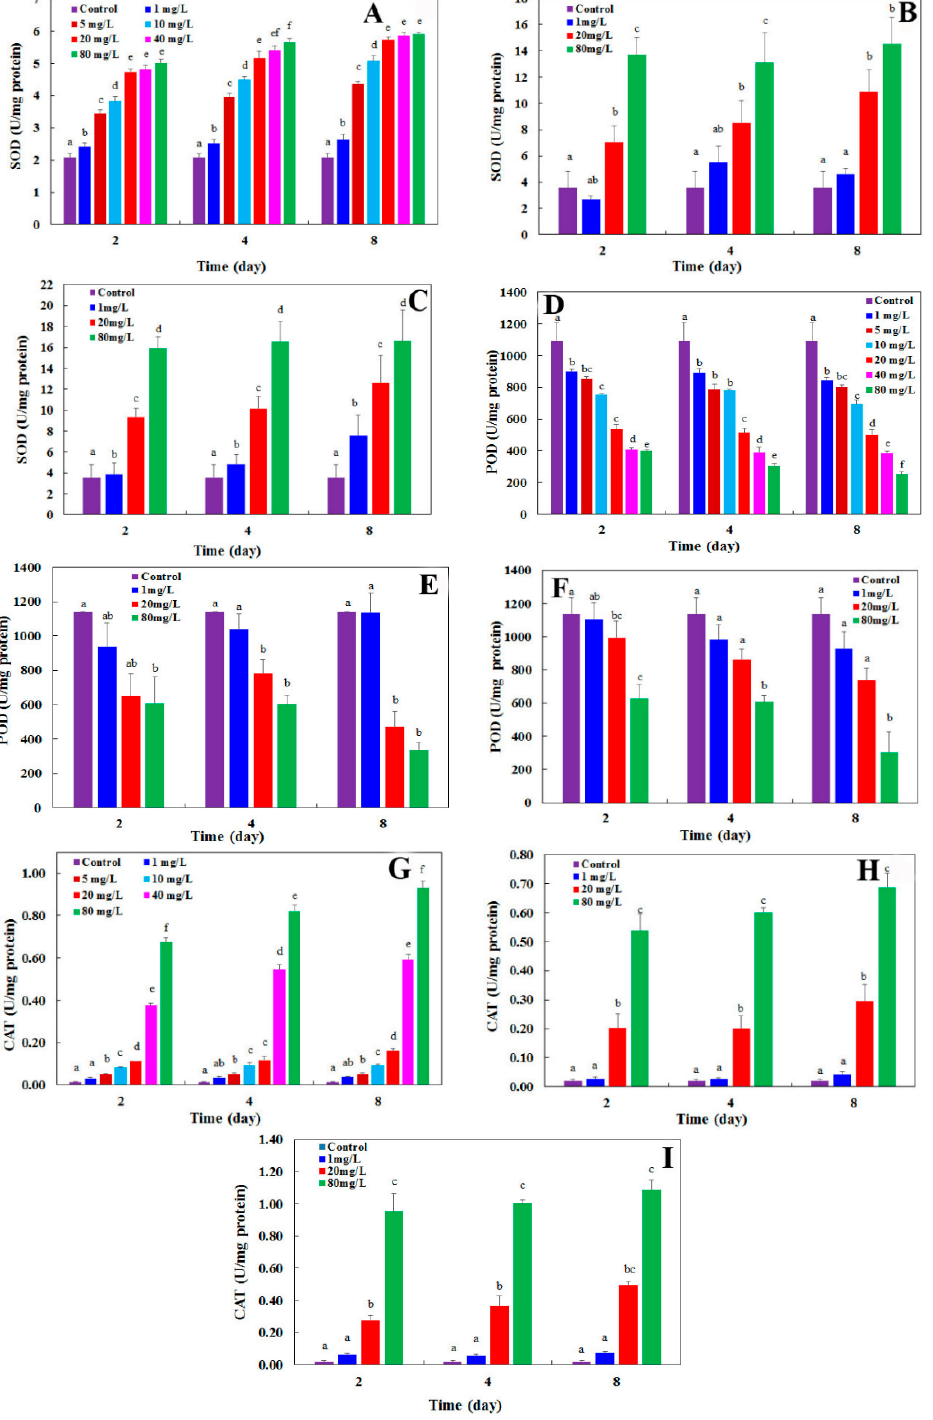
Figure 5. ( A – C ) superoxide dismutase (SOD), ( D – F ) peroxidase (POD), and ( G – I ) catalase (CAT contents in Lemna minor influenced by increasing concentrations of CdSe NPs as well as Cd(CH 3 COO) 2 and CdSO 4 respectively on the 2nd, 4th, and 8th days after treatment. Different letters indicate significant differences at p ≤ 0.05 according to Tukey’s HSD Test. The error bars represent standard deviation of the mean ( n = 3 replicates).